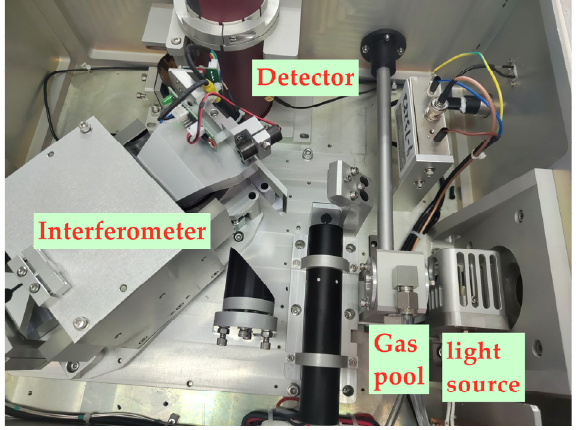
Figure 2. The experimental equipment diagram of the OP-FTIR.